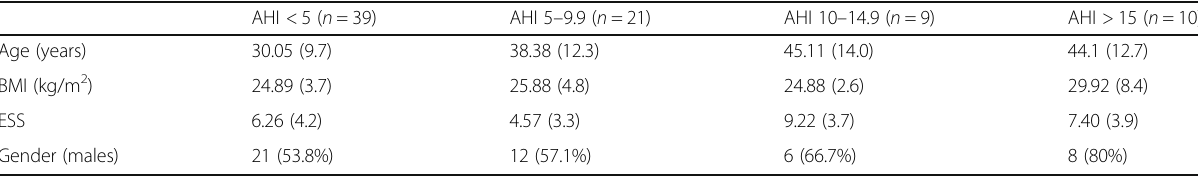
Table 2 Stratification of OIP group according to the apnea – hypopnea index